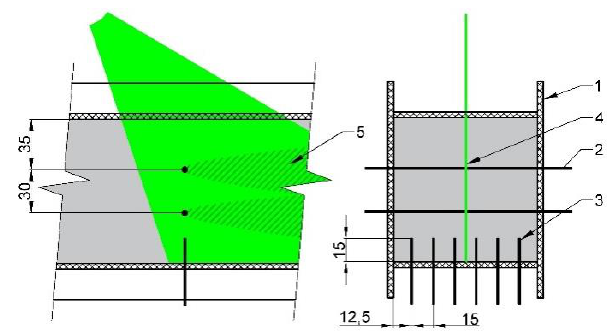
Fig. 2. Measuring area for visualization. 1 channel wall, 2 cylinders placed within the flow, 3 thermocouples, 4 laser sheet, 5 vortex structures illuminated by the laser sheet.